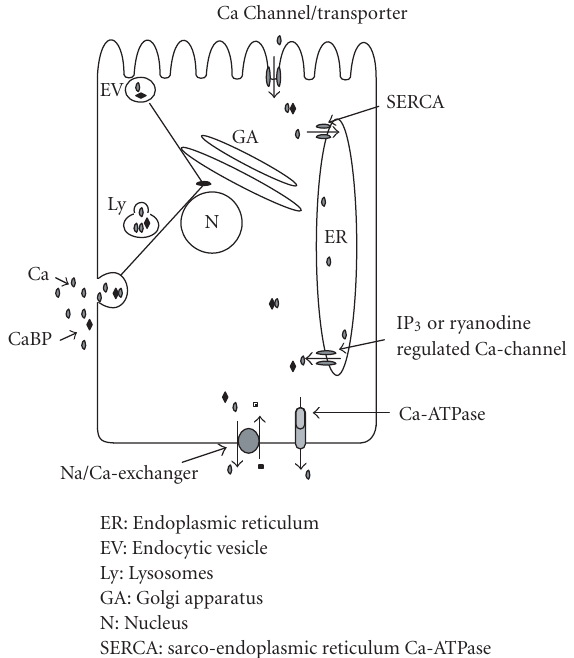
Figure 1. Vectorial transcellular calcium transport in intestinal epithelium. Three distinct but potentially complementary pathways are depicted: (1) uptake and transport of calcium (and calbindin) by vesicles/lysosomes with transport along microtubules, and fusion with the basolateral membrane to complete delivery of the cation; (2) entry of calcium into the cytoplasm with binding to calbindin and di ff usion to the basal lateral membrane for extru- sion by Ca-ATPase; (3) entry of calcium into the cytoplasm and uptake by the ER, di ff usion through the ER, and extrusion of calcium in the vicinity of Ca-ATPases and